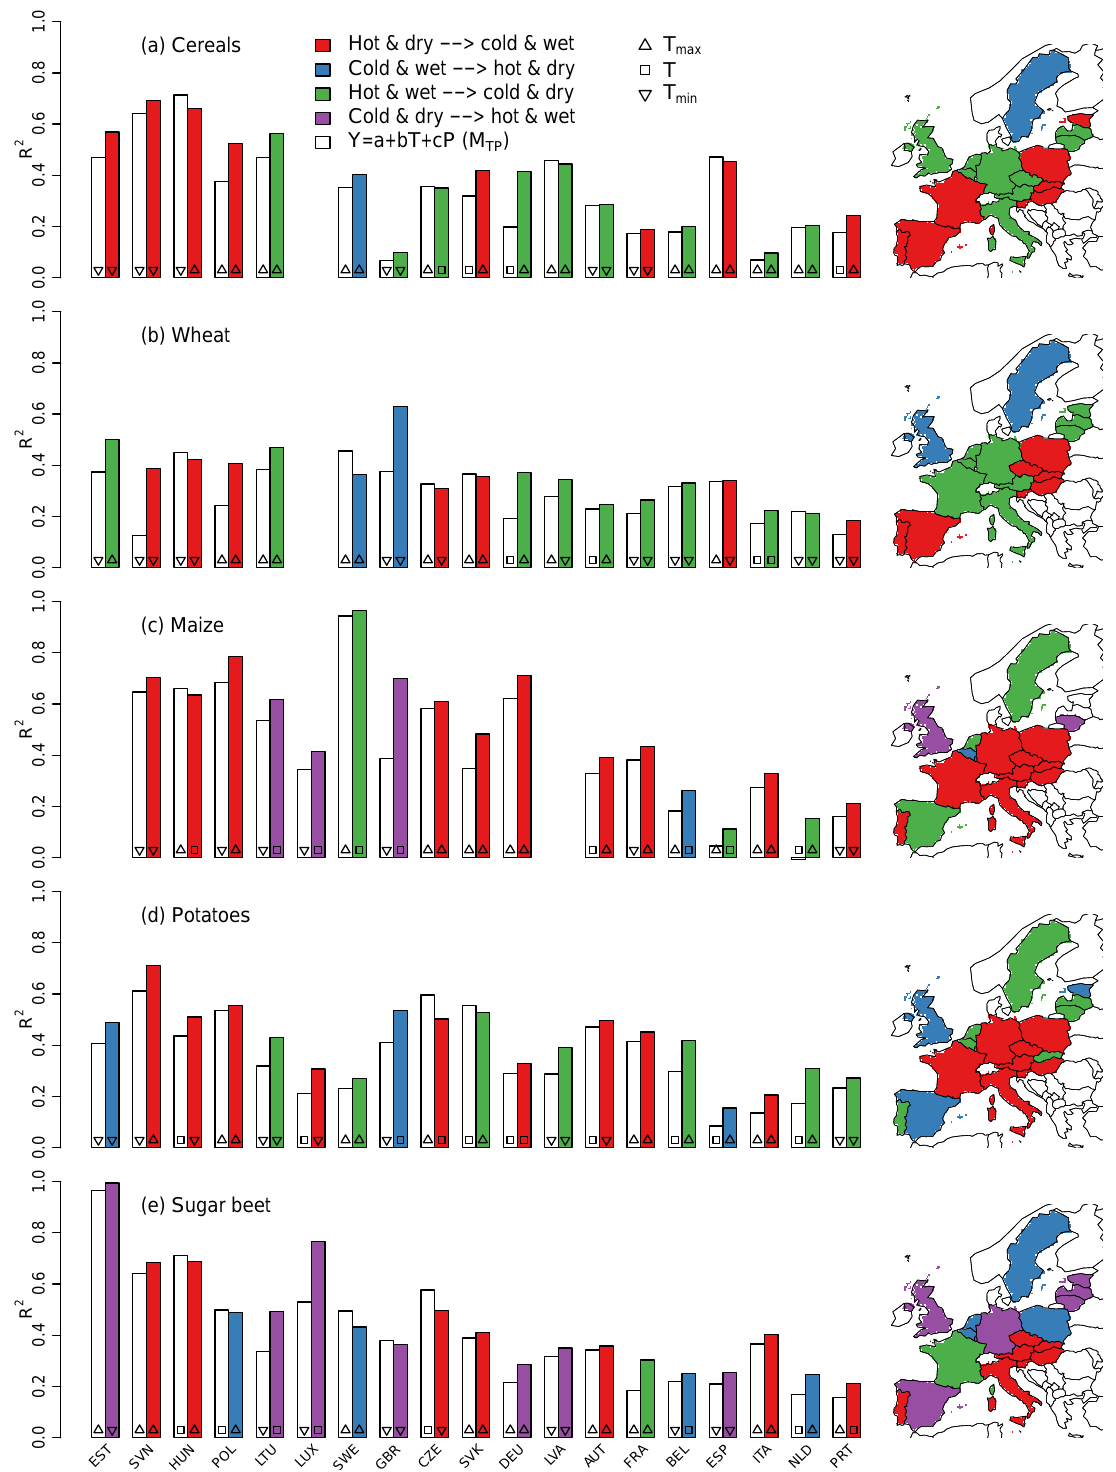
Figure 5. Summary of all R 2 derived from linear models using either return periods ( M rp , coloured bars) or temperature and precipitation anomalies ( M TP , white bars) as predictors for yield anomalies. The temperature variable that was used ( T max , T , T min ) is denoted with symbols at the bottom of each bar. Yield anomalies co-vary positively with the climate gradients along the four directions denoted by the legend. Countries are sorted by the average performance of the models M rp